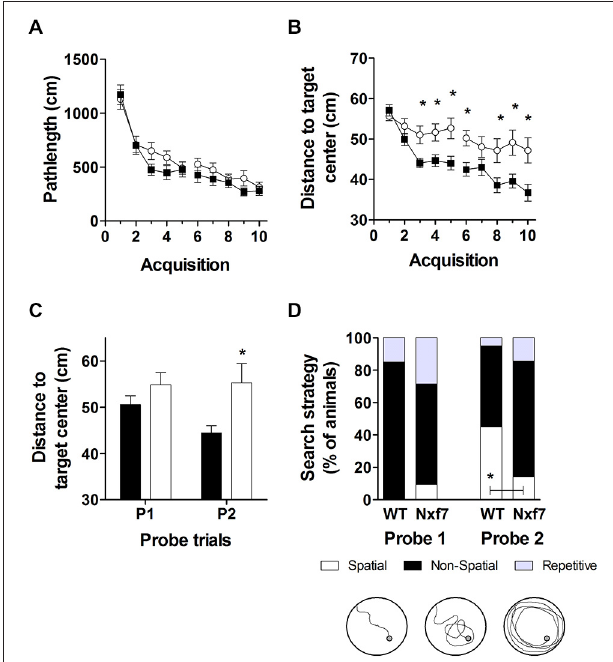
FIGURE 3 | Spatial learning in the Morris water maze was impaired in Nxf7 KO (white symbols, N = 21) mice compared to WT (black symbols, N = 20) mice. While no difference was found in total path length (A) , Nxf7 KO were less efficient in finding the platform and average distance to the hidden platform was significantly reduced during acquisition (B) and during interspersed probe trials (C) . Results are presented as means ± SEMs. Search strategy analysis of the probe trials (D) indicated that 45% of WT animals employed spatial search strategies in the period after the first virtual platform crossing during the second probe trial In contrast, most Nxf7 KO mice (71%) relied on non-spatial strategies to search for the platform in the post-period. Tracks are depicting schematic representation of search strategies (for detailed information see Lo et al., 2013a, 2014). Data are presented as ratio. * p < 0.05 comparing to WT. See text for details.